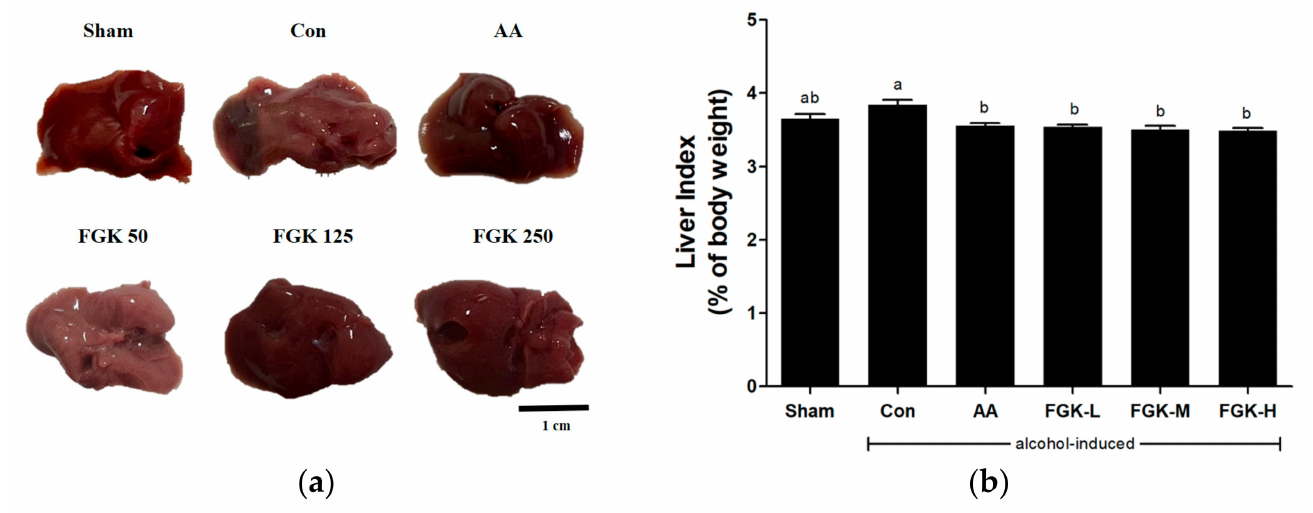
Figure 1. Effects of fermented gold kiwi (FGK) on the liver index of alcohol-induced mice. ( a ) Gross examination of mouse liver; ( b ) liver index levels. Sham, mice treated with only saline; Con, mice treated with alcohol and saline; AA, mice treated with alcohol and ascorbic acid 25 mg/kg; FGK-L, -M, -H, mice treated with alcohol and FGK at 50, 125 and 250 mg/kg, respectively. Results are expressed as means ± SEM ( n = 8). a,b Different letters indicate significant differences p < 0.05 among the groups, as determined by Tukey’s